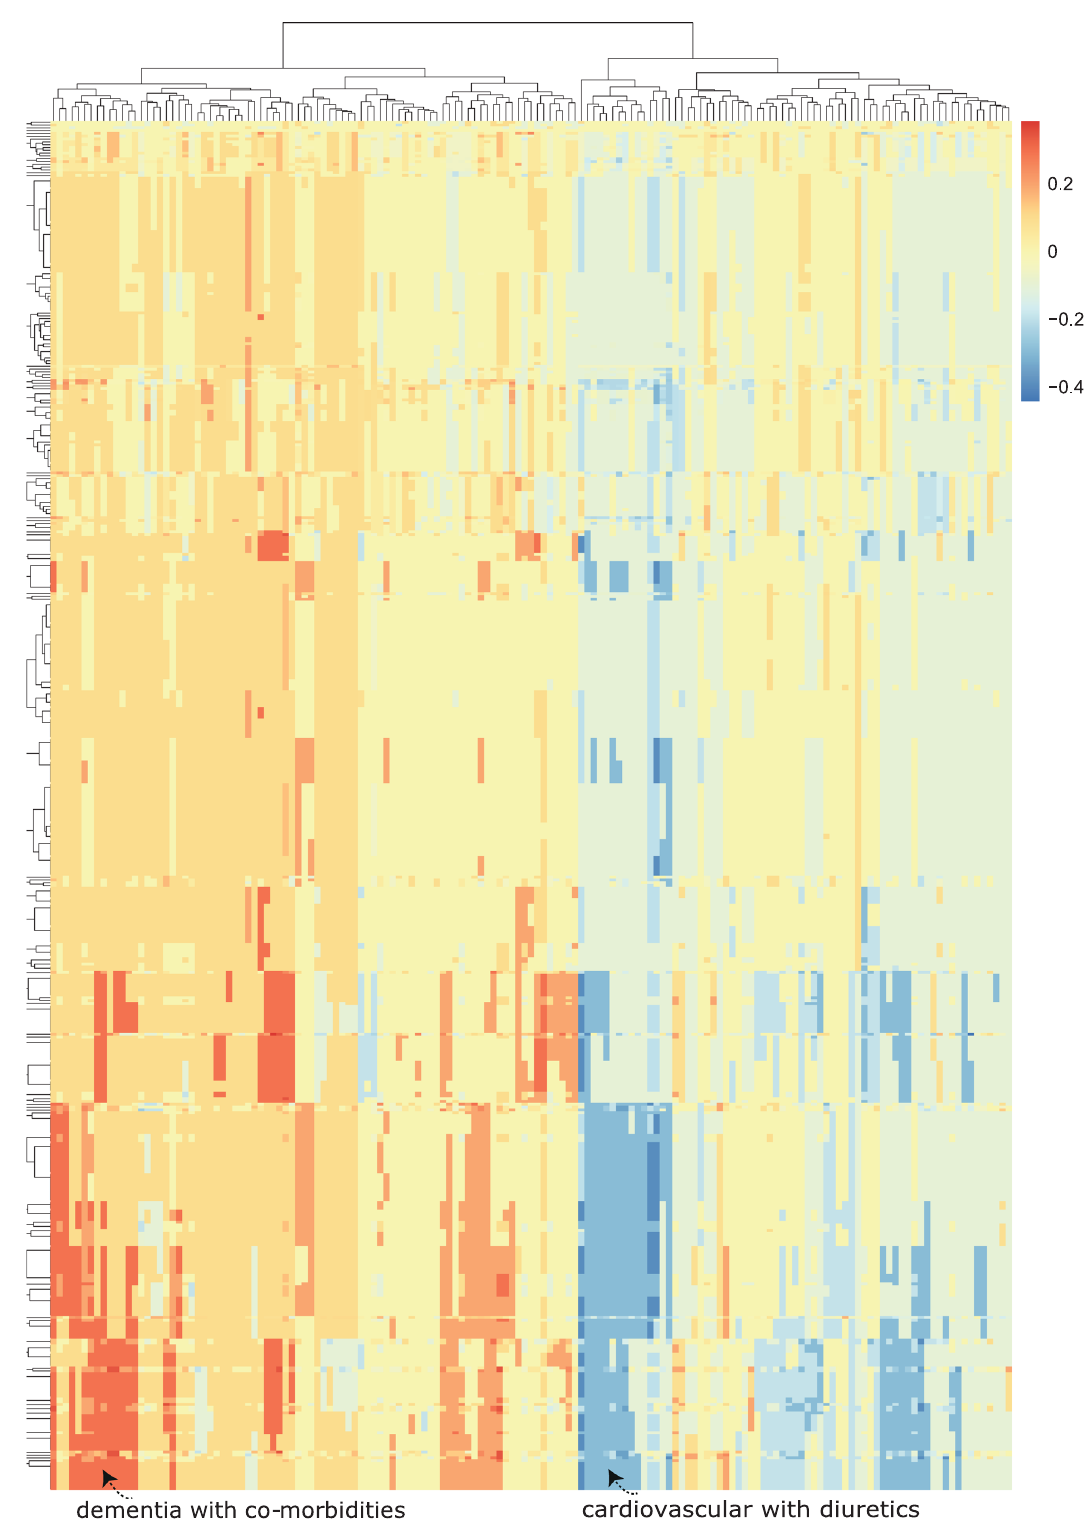
Fig. 7 Advanced class-contrastive heatmap for the deep learning model. Class-contrastive heatmap for deep learning models showing the effect of combinations of features. Visualization of the amount of change predicted in the probability of death by setting a particular combination of two features to 1 simultaneously (versus 0). Rows represent patients and columns represent feature groupings (all combinations of two features). Predictions are made on the test set using a random forest model built on top of the autoencoder. Delirium and dementia in Alzheimer ’ s disease seem to predispose some patients towards greater risk of mortality (shown in the lower left region of the heatmap in red). Diuretics appear to be associated with lower mortality in a group of patients with cardiovascular disease (shown in the blue region in the lower right-hand corner of the heatmap). The heatmap also shows a hierarchical clustering dendrogram which is performed using an Euclidean distance metric and complete